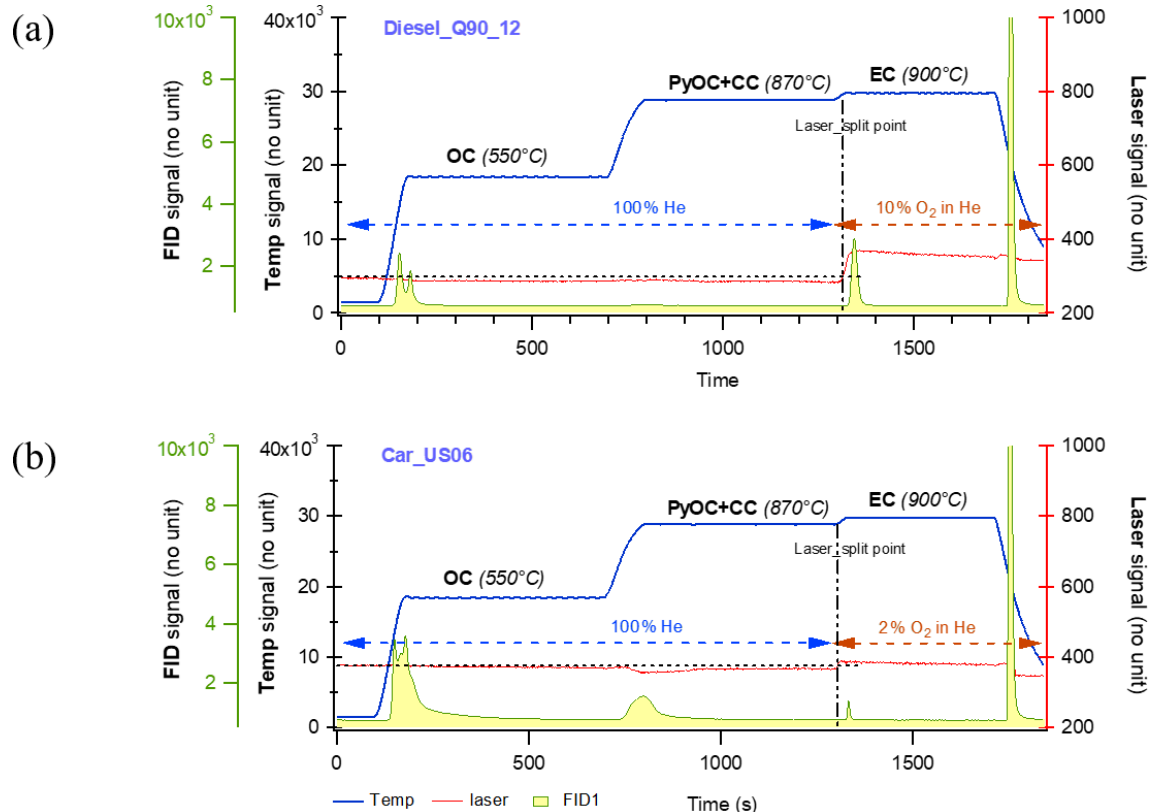
Figure 7. Thermograms of the filters directly collected from tailpipe exhaust of a diesel engine vehicle in (a) and a gasoline engine passage car in (b) . The legends are the same as Fig. 6. Note that the mass fraction from the temperature stage of 870 ◦ C in (b) is obviously larger than that in (a) . The latter is negligible, indicating that the amount of PyOC fraction is sample matrix dependent. The amount of PyOC from gasoline vehicle emissions is likely larger than that from diesel vehicle emissions. Note that the laser signal reaches the initial value before the 900 ◦ C stage for EC releasing, demonstrating that the charring contribution to EC is